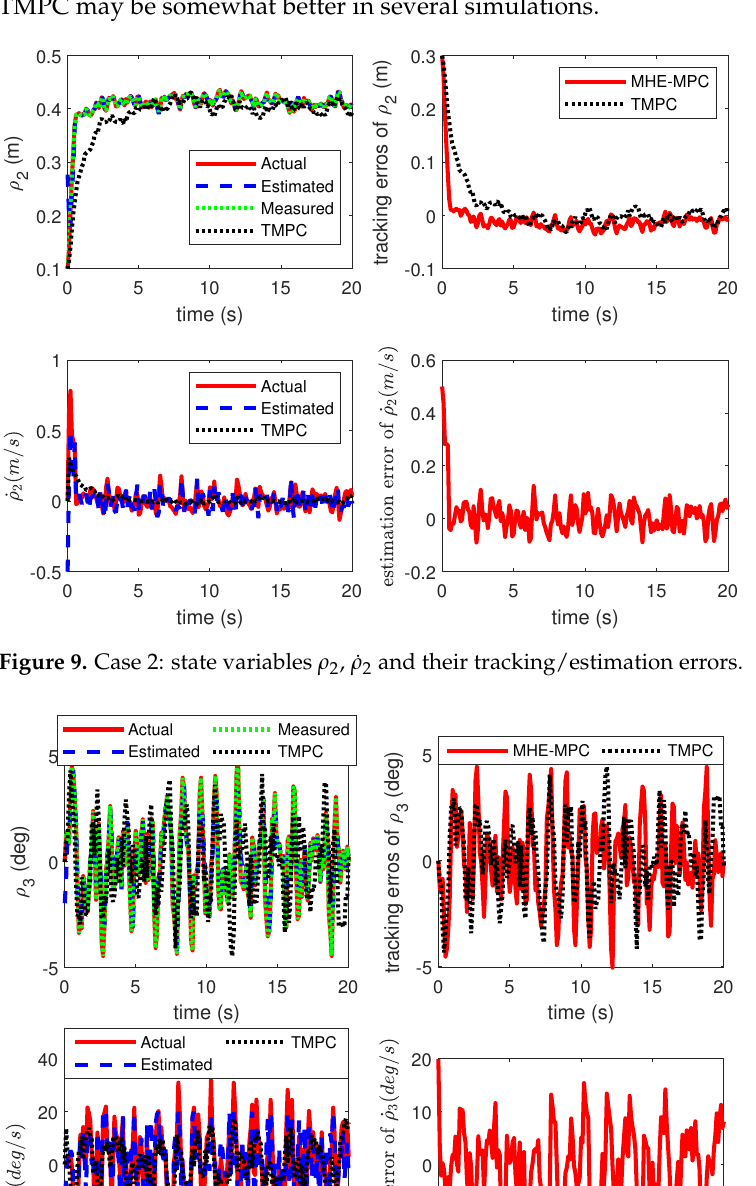
Figure 9. In Figure 10, antiswing effects are equivalent. In short, a lightly better performance for state vector ρ arises in the MHE-MPC approach.